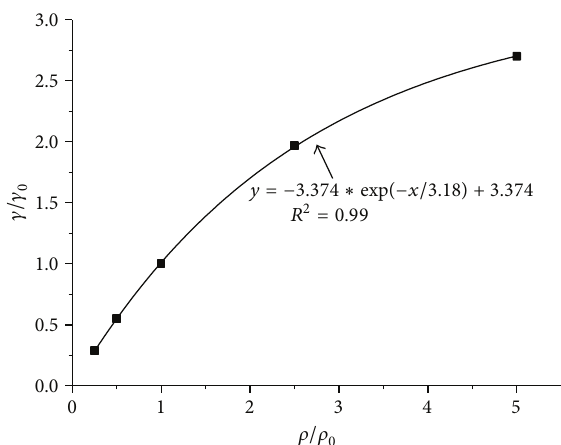
Figure 17: Effect of reinforcement ratio on reduction of concrete